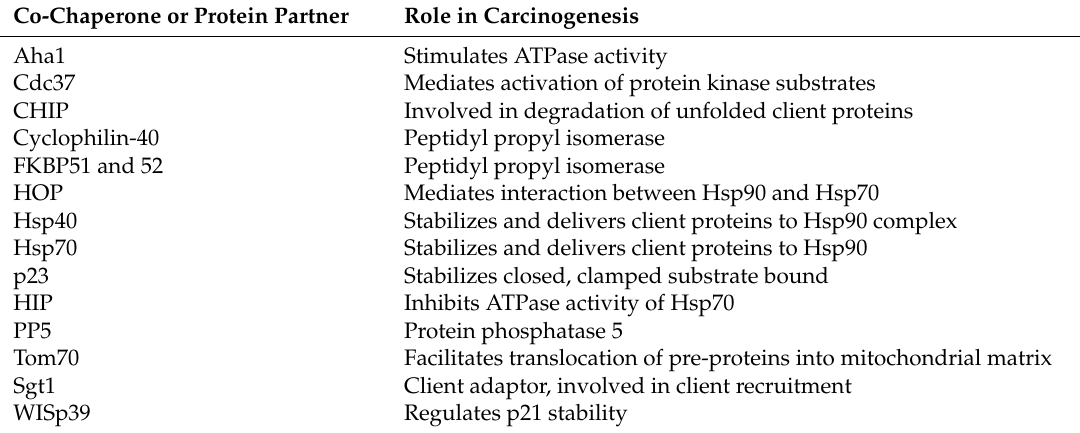
Table 2. Contributing co-chaperons and proteins in the HSP90 chaperone folding cycle [44,69].